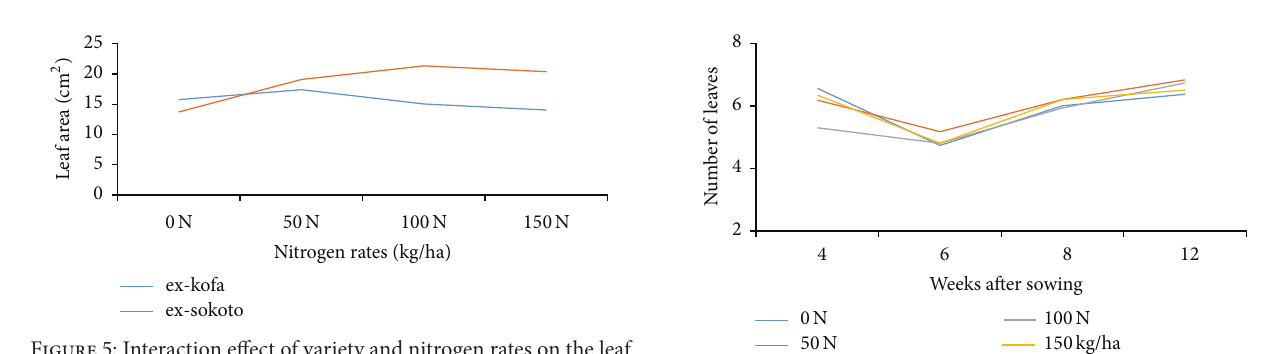
Figure 5: Interaction effect of variety and nitrogen rates on the leaf area at 6WAS (LSD = 4.54 ).